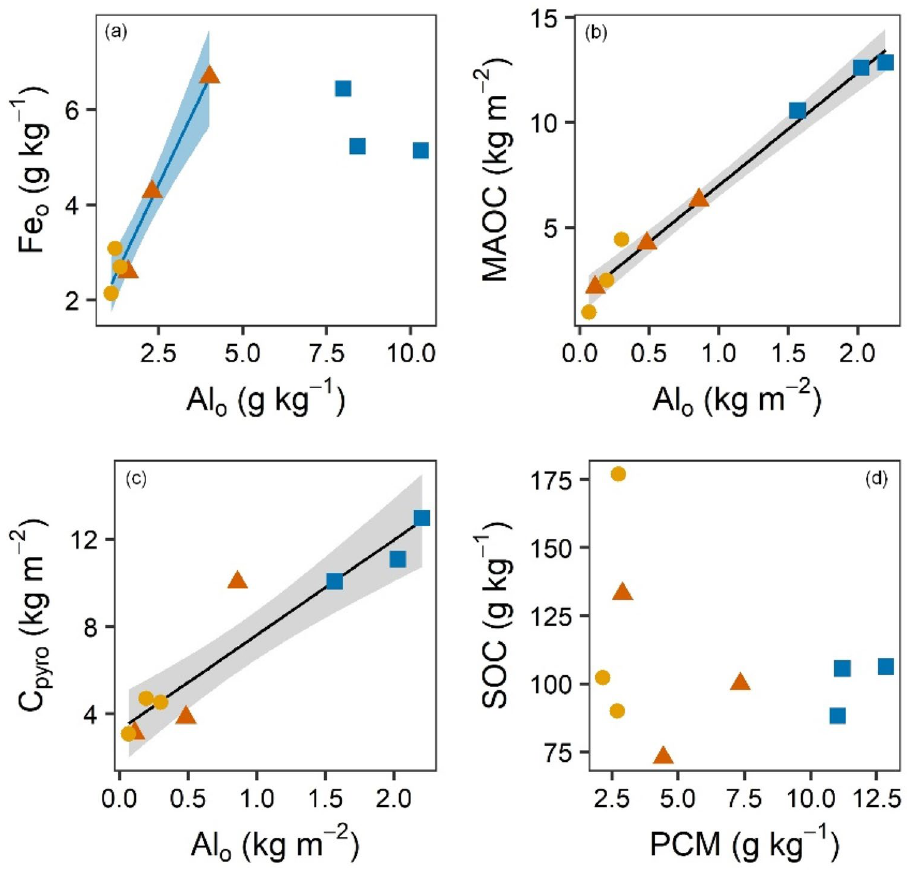
Figure 2. Relationships between ( a ) oxalate extractable iron (Fe o ) and aluminum (Al o ), ( b ) mineral associated organic carbon (MAOC) and oxalate extractable aluminum (Al o ), and ( c ) pyrophosphate extractable carbon (C pyro ) and poorly crystalline minerals, and ( d ) total soil organic carbon (SOC) and poorly crystalline minerals (PCM). Concentrations given as the soil mass-weighted mean of depth increments of individual profiles, stocks are the sum of stocks of the depth increments. Squares: managed pasture (MP), triangles: pristine grassland (PG), circles: pristine forest (PF). Shaded area indicates the 95% confidence interval of the linear model